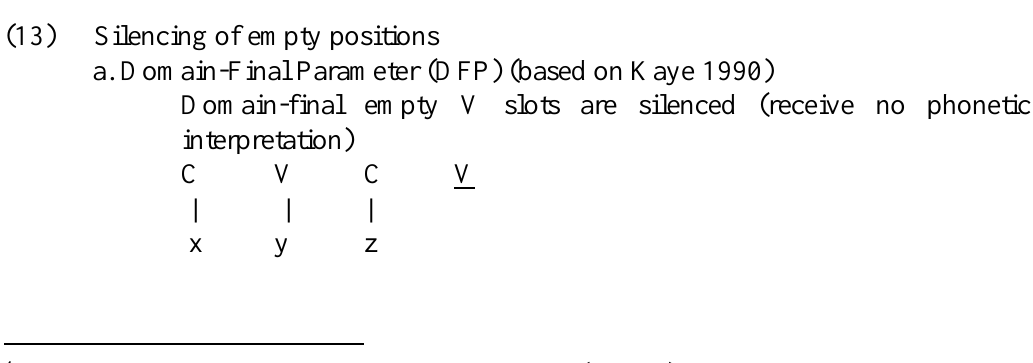
Association lines added by the computation (linking) are shown as dotted, underlying ones are shown as